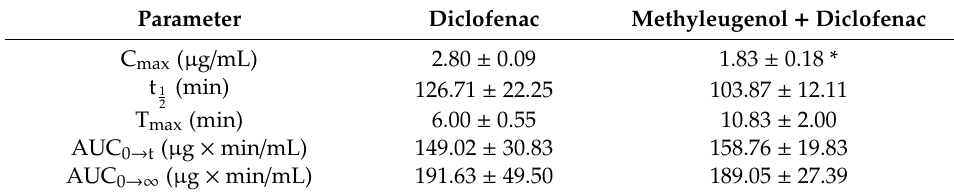
Table 3. Parameters of pharmacokinetics determined after the oral administration of the vehicle plus diclofenac (15.08 mg / kg) or methyleugenol plus diclofenac (3.99 and 15.08 mg / kg, respectively) to rats. Data are expressed as the mean ± SEM ( n = 6).